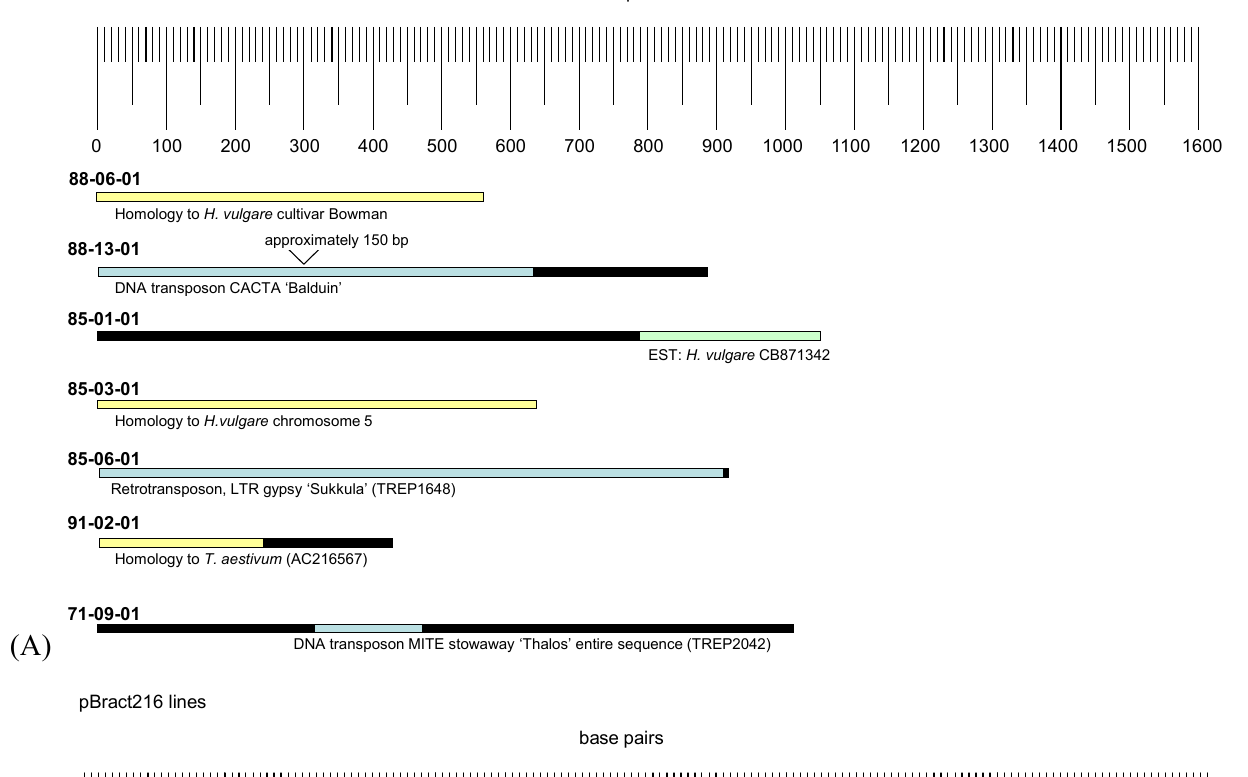
Figure 3. Alignments identified between T-DNA flanking DNA and sequences within the public databases. Flanking sequences for lines transformed with different constructs are given as follows: ( A ) lines containing pBract215, ( B ) lines containing pBract216, ( C ) lines containing pBract217. Blue sequences were homologous to known repetitive elements, green to ESTs and yellow to unannotated genomic DNA. Black sequences showed no significant homology to sequences within the public databases searched. Gaps in sequences (resulting from obtaining two or more non-overlapping sequences) are indicated, with approximate sizes